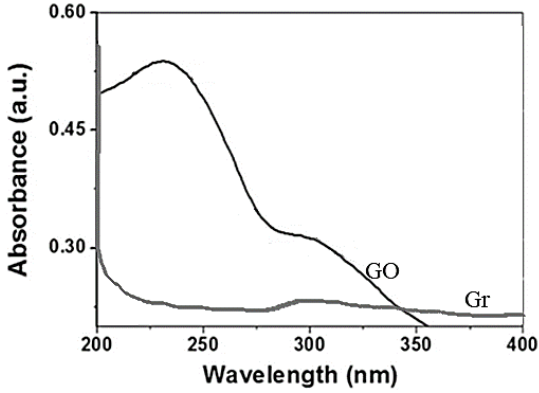
Figure 3. UV–Vis spectra corresponding to Gr and GO samples.